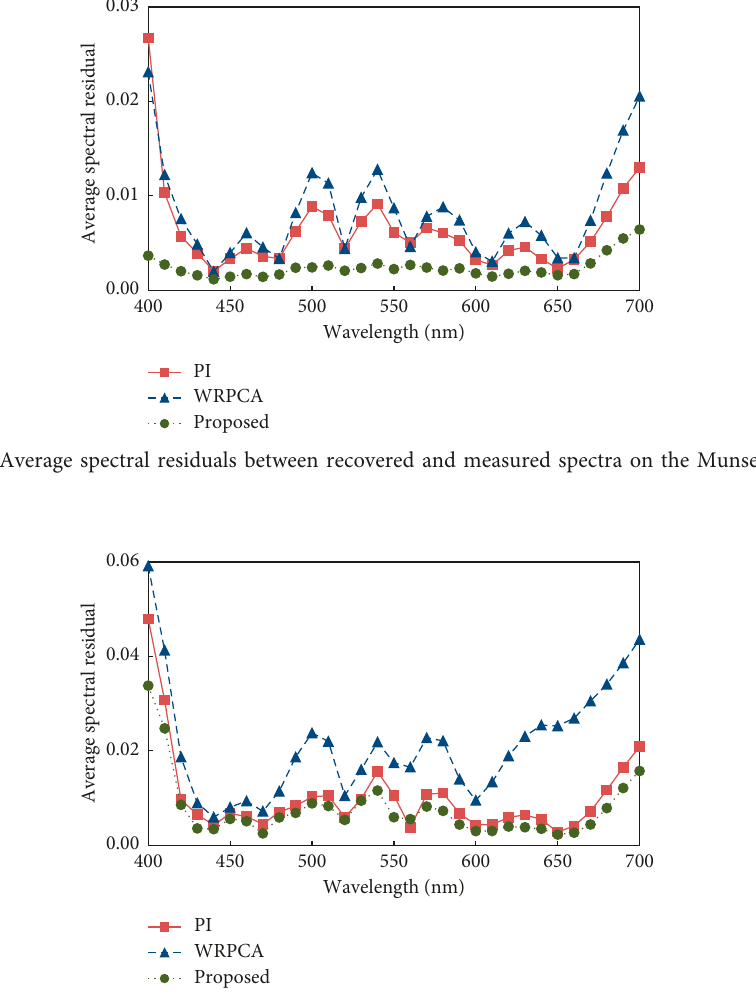
Figure 3: Average spectral residuals between recovered and measured spectra on the ColorChecker